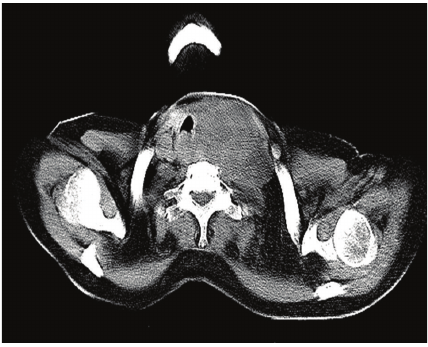
Figure 2: CECT neck showing a 5.9 cm × 4.3 cm lesion involving theleftlobeofthyroidandisthmusencasingtheleftcommoncarotid artery and subclavian artery and extending into the left carotid space and anterosuperior mediastinum.